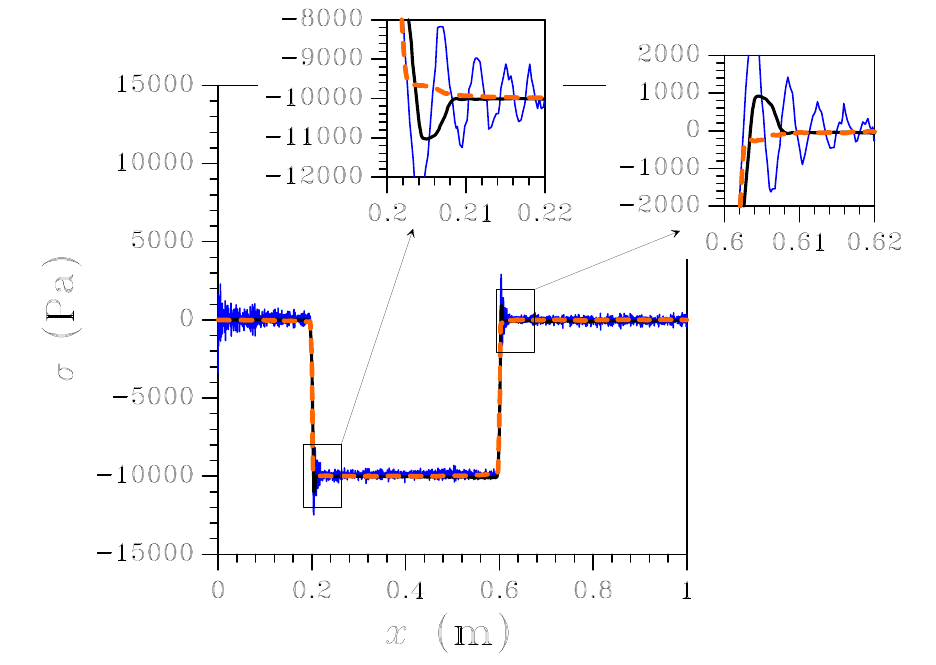
Figure 6. Wave propagating along a homogeneous rod discretized with an unstructured mesh: stress field at t = 1 . 8 · 10 − 2 s. Blue solid line: FE solution; black solid line: standard FE-FCT solution; orange dashed line: newly proposed FE-FCT